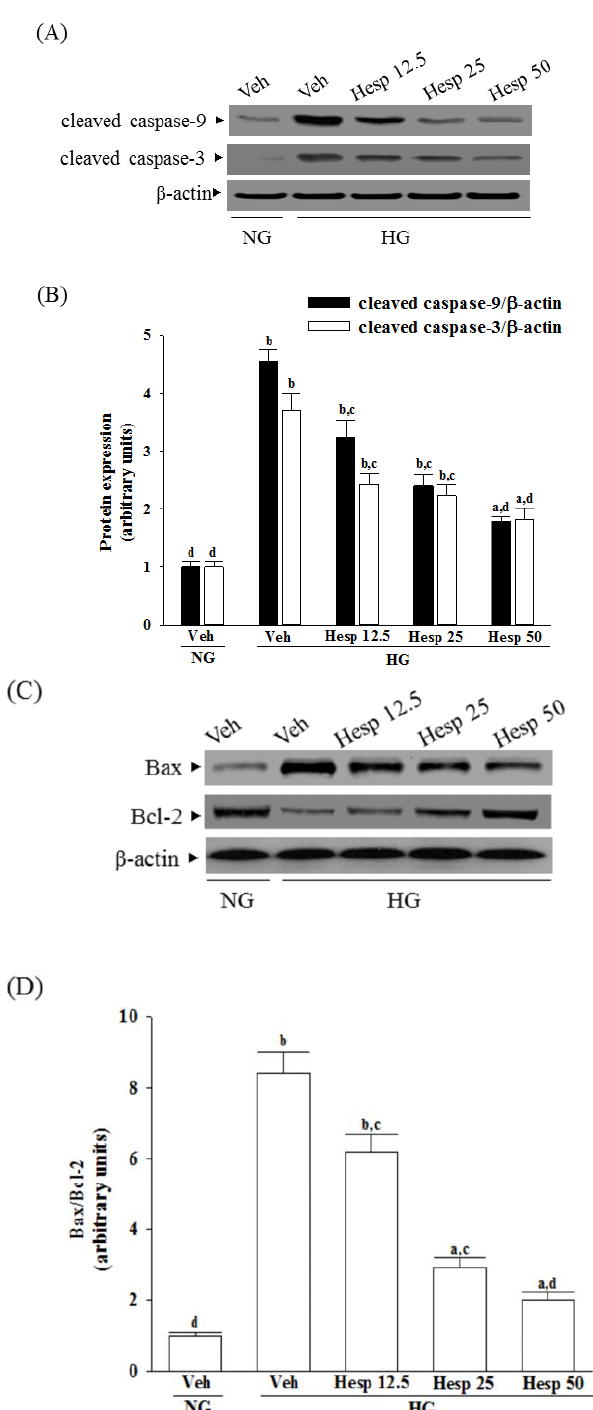
Figure 4. Effects of hesperidin on protein expression related to apoptosis in RGC-5 cells under high glucose conditions. The RGCs were cultured with normal (NG) or high glucose (HG) plus hesperidin at concentrations of 12.5 (Hesp 12.5), 25 (Hesp 25), or 50 µ mol/L (Hesp 50) for 48 h. ( A ) Protein bands of cleaved caspase-9 and cleaved caspase-3 in RGC-5 cells detected by Western blotting; ( B ) Quantitative densitometric analysis of caspase-9 and cleaved caspase-3; ( C ) Protein bands of Bax and Bcl-2 in RGC-5 cells detected by Western blotting; ( D ) Changes of the ratios of Bax/Bcl-2 are displayed in the bottom panel. The results are presented as the mean ± SD of five independent experiments ( n = 5), each of which was performed in triplicate. a p < 0.05 and b p < 0.01 when compared with the normal ‐ glucose vehicle (Veh) ‐ treated group. c p < 0.05 and d p < 0.01 when compared with the high ‐ glucose vehicle ‐ treated group.